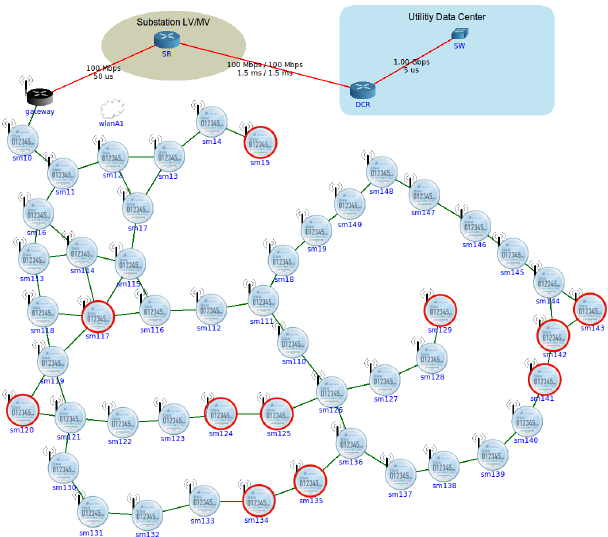
Figure 6. WMN scenario to deploy Smart Meters emulated on Core Emulator.